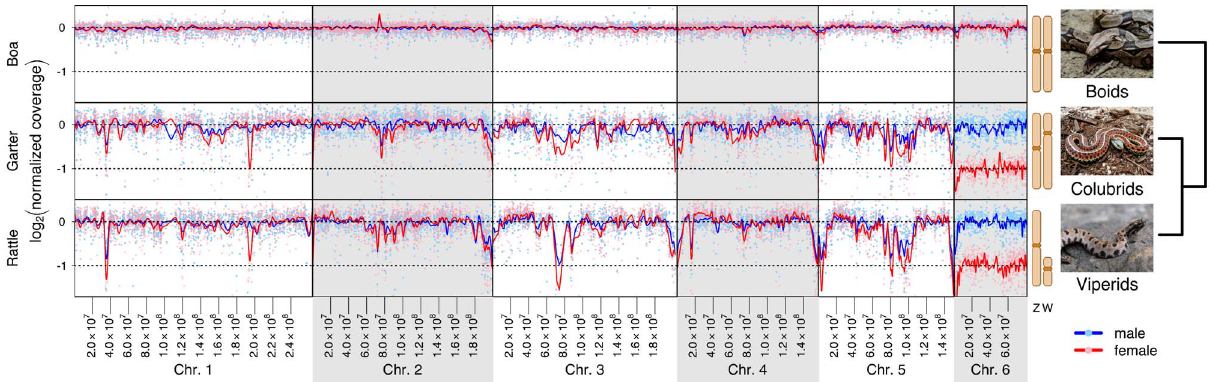
Figure 1. Normalized read coverage depth for female (red) and male (blue) scaffolds ordered along the Anolis genome for (A) boa, (B) garter snake, and (C) pygmy rattlesnake. The points show the normalized log 2 coverage for each scaffold and the lines represent a smoothing spline drawn along the chromosome. Coverage was normalized by dividing the coverage for each scaffold-by-sex combination by the median coverage of all scaffolds in chromosomes 1–5 in that sex, resulting in a median log 2 coverage score for autosomes of 0. Under this normalization, hemizygous sequences are expected to have a median log 2 coverage of 2 1. Scaffolds were mapped to the Anolis macrochromosomes on the basis of the location of their gene content. The phylogenetic relationship between the species investigated is shown. Boids split from the other two groups about 100 MY ago, while colubrids and viperids diverged about 50 MY ago [8]. The snake photographs are used under a Creative Commons Attribution 2.5 Generic license (CC BY 2.5). Credit for the photographs are as follows: Nick Turland for the western pygmy rattlesnake (http://www.flickr.com/photos/nturland/1436776818/); Guilherme Jo´fili for the Boa constrictor (http://www.flickr.com/photos/gjofili/5005623645/); Steve Jurvetson for the coastal garter snake (http://www.flickr.com/photos/jurvetson/825514494/). Additional permission to publish the western pygmy rattlesnake image was granted by Nick Turland.